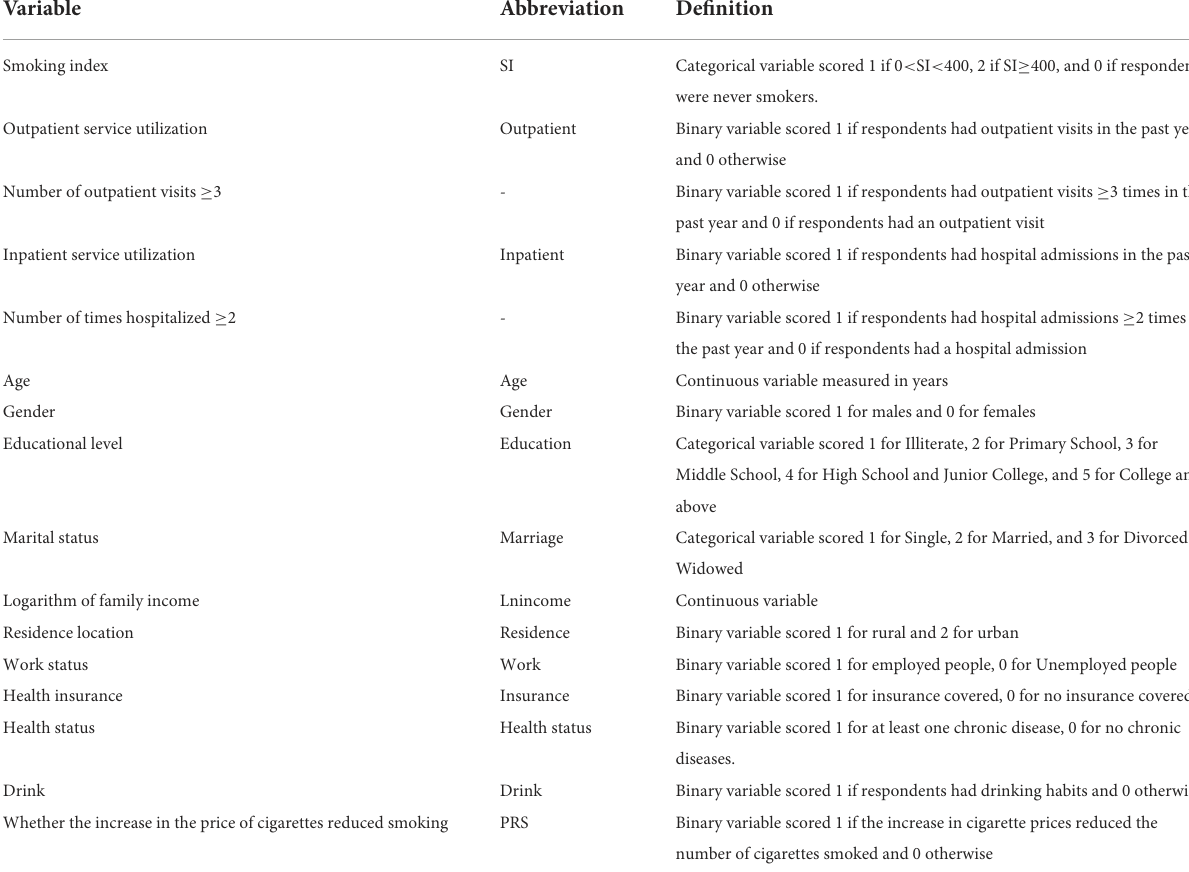
TABLE 1 The definition and abbreviation of selected variables in the